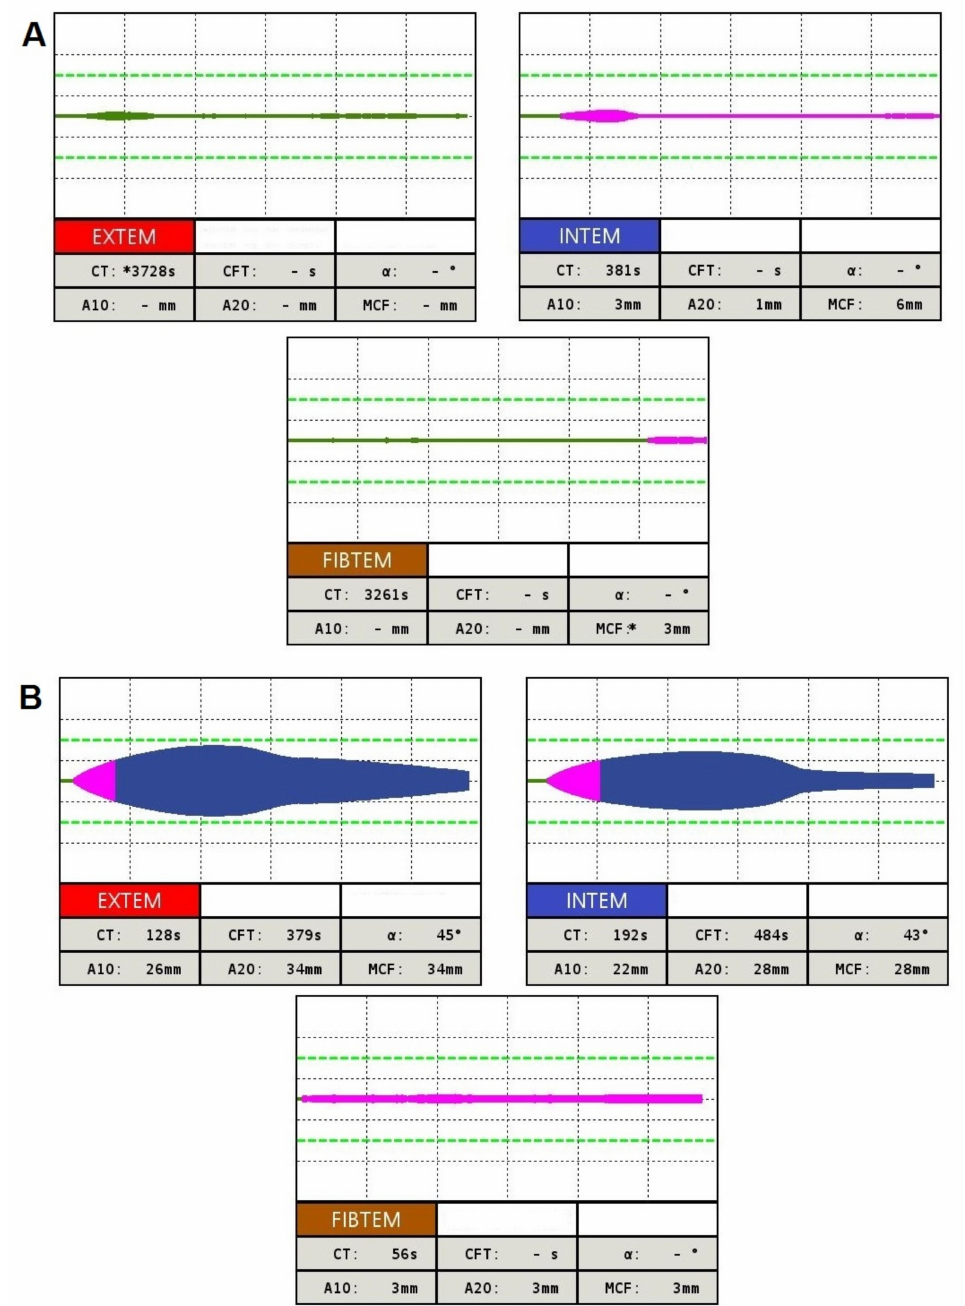
Figure 1. Results of rotational thromboelastometry in Family 1 patient with afibrinogenemia ( A ) and Family 2 patient with hypofibrinogenemia ( B